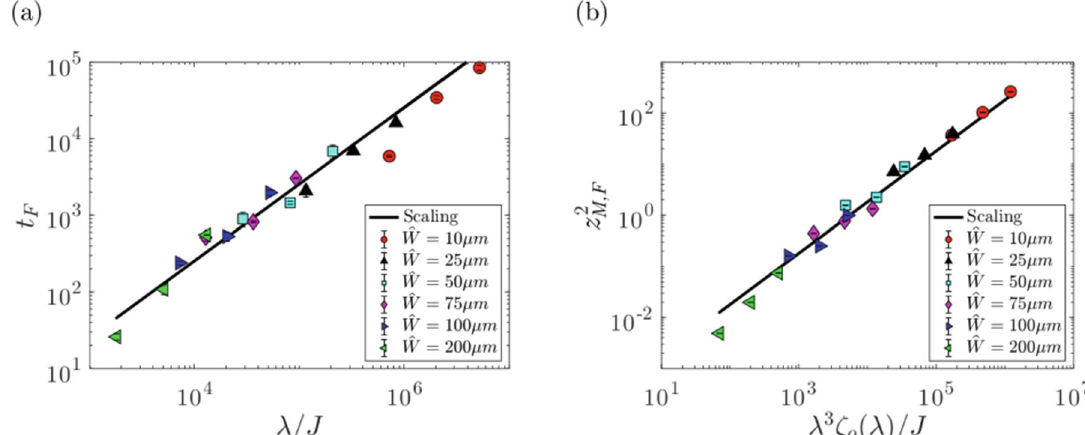
Fig. 3 Scaling relationships. Scaling relationships for ( a ) dimensionless fi nal time t F ¼ ^ t F ^ σ = ^ μ ^ W and ( b ) square of the dimensionless fi nal ¼ ^ z 2 = ^ W 2 , for different channel widths ^ W 14 . The solid lines represent the proposed scaling relationships and the solid meniscus position z 2 M ; F M ; F symbols represent experimental results by Lade et al. 37 . All channel heights ^ H are 46.8 μ m. The channel aspect-ratio function ζ 0 ( λ ) can be found in the work of Ouali et al. 24